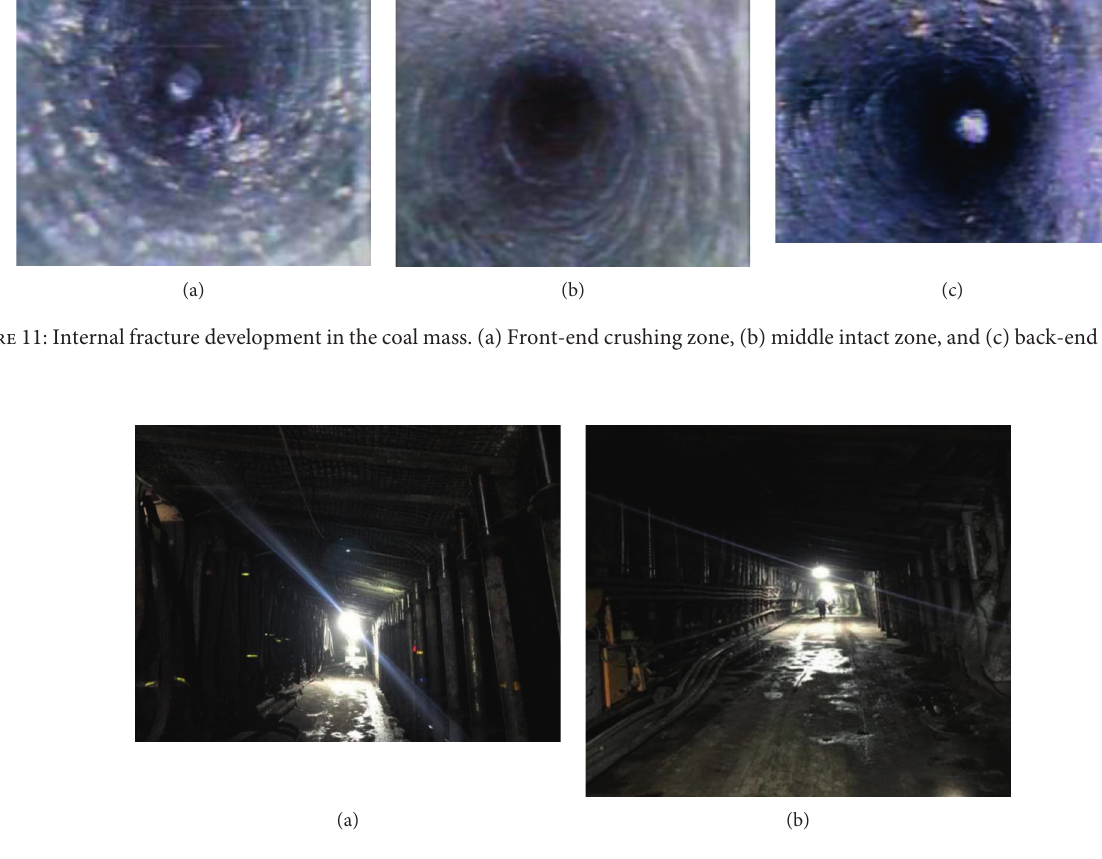
Figure 12: Effects on the roadway with 50 and 100m of working face advancement. (a) 50m of advancement and (b) 100m of